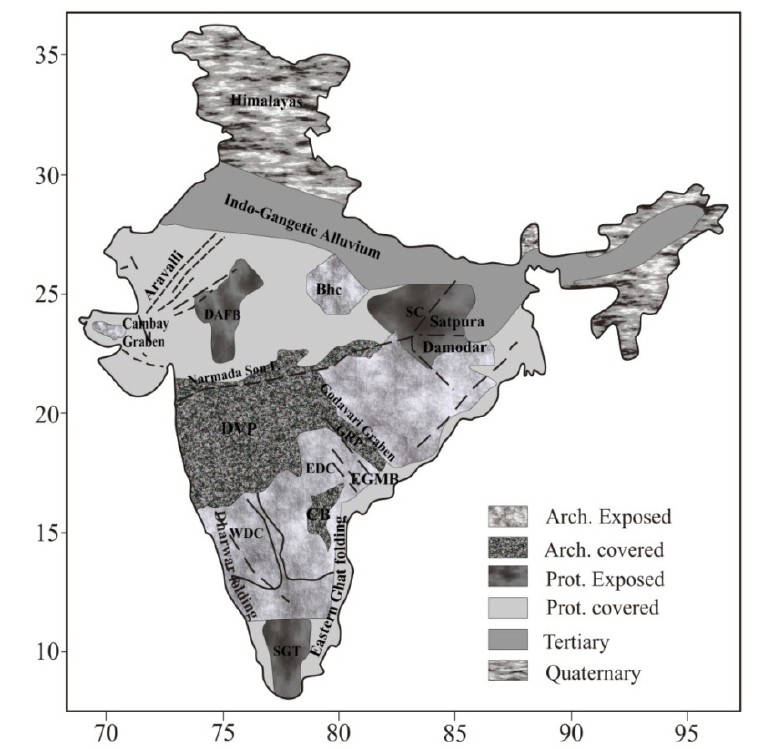
Figure 1. Geotectonic map of the whole Indian shield, indicating the ages of the different zones. The map is modified after Rajesh and Mishra [2004]. Abbreviations: BC, Bhandara craton; Bhc, Bundelkhand complex; CB, Cudappah Basin; DAFB, Delhi Aravalli fold belt; DVP, Deccan volcanic province; EDC, Eastern Dharwar craton; EGMB, Eastern Ghat Mountain belt; GRP, Godavari Rift province; SC, Singbhum craton; SGT, Southern Granulite Terrain; WDC, Western Dharwar